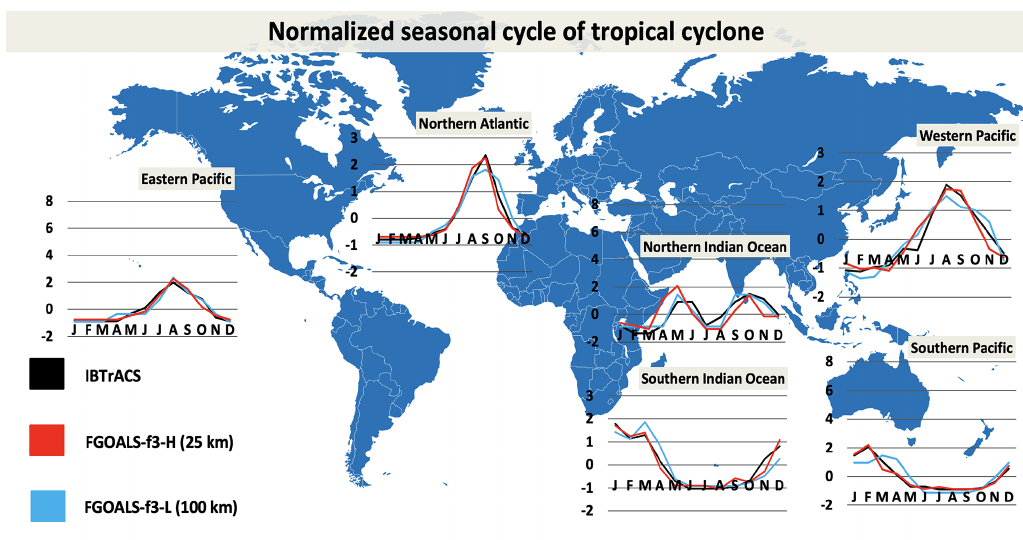
Figure A1. Seasonal cycle of tropical cyclones with zero-mean normalization in the western Pacific, southern Pacific, northern Indian, northern Atlantic, southern Indian and eastern Pacific oceans (units: number of cyclones) during the time period 1991–2014.